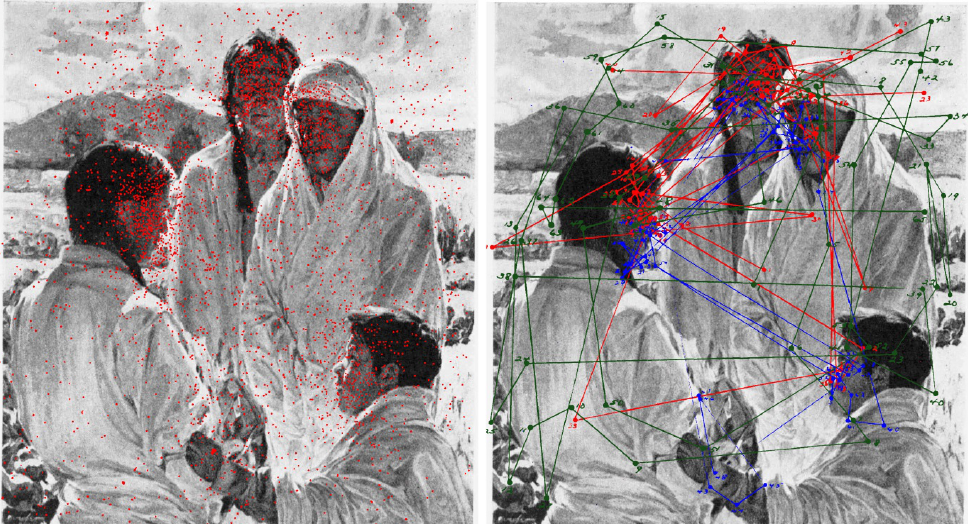
Figure 13. Fixations and faces . Left, locations of eye fixations (in red) for 76 observers over The solemn pledge – Taos Indians by Walter Ufer. Right, eye movement patterns of three observers (in red, green and blue) over the picture. (Adapted from Picture 12 and Plates IX, XXXV, XXXVI and XXXVII in Buswell,